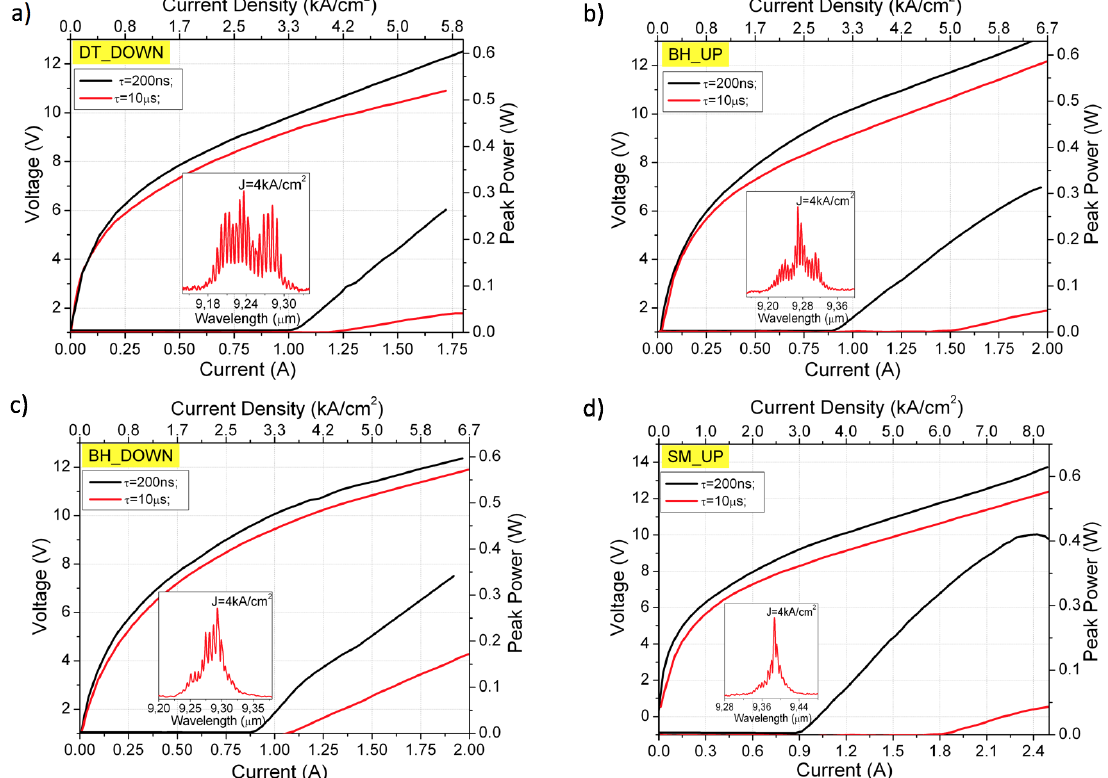
Figure 4. Light-current-voltage (LIV) characteristics for investigated QCLs: ( a ) DT epi-layer down mounted, ( b ) BH epi-layer up mounted, ( c ) BH epi-layer down mounted, and ( d ) SM epi-layer up